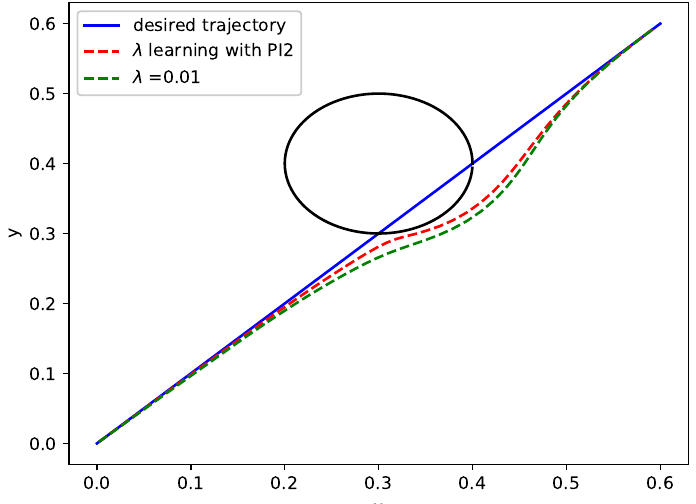
Figure 3. Obstacle avoidance behavior with RL algorithm: PI2.